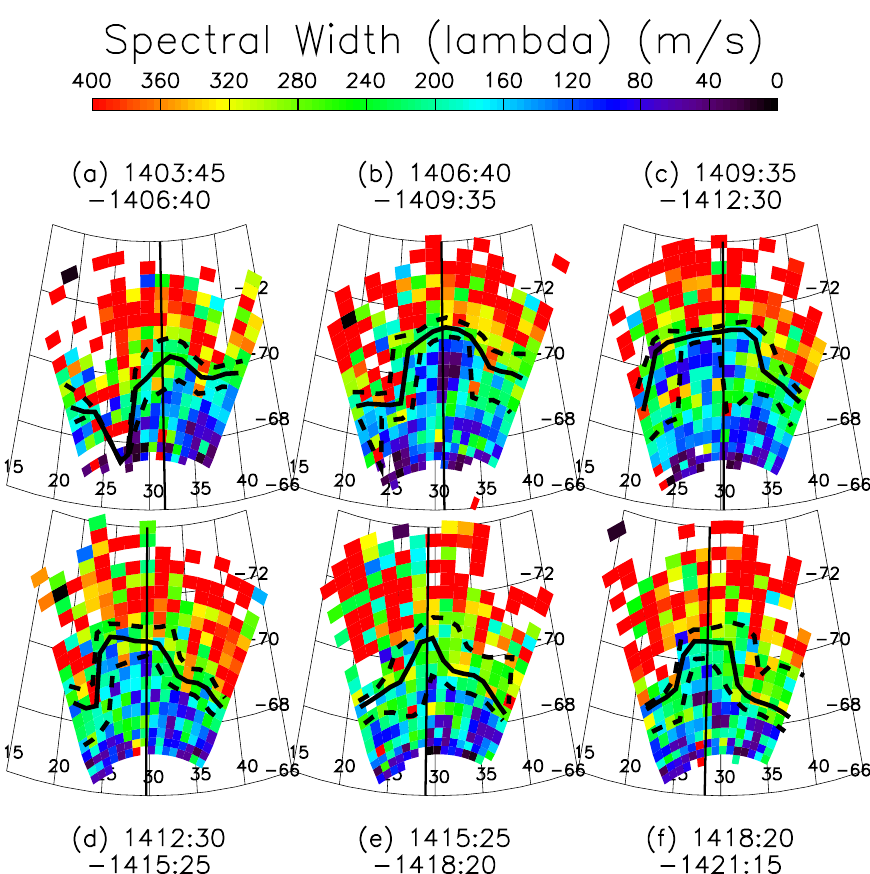
Fig. 3. The spectral width variation in six consecutive scans from the Halley radar on 20 August 1998. The bold line enclosed by two dashed lines represents the spectral width boundary and its uncertainty, respectively. The solid vertical line marks the longitude of